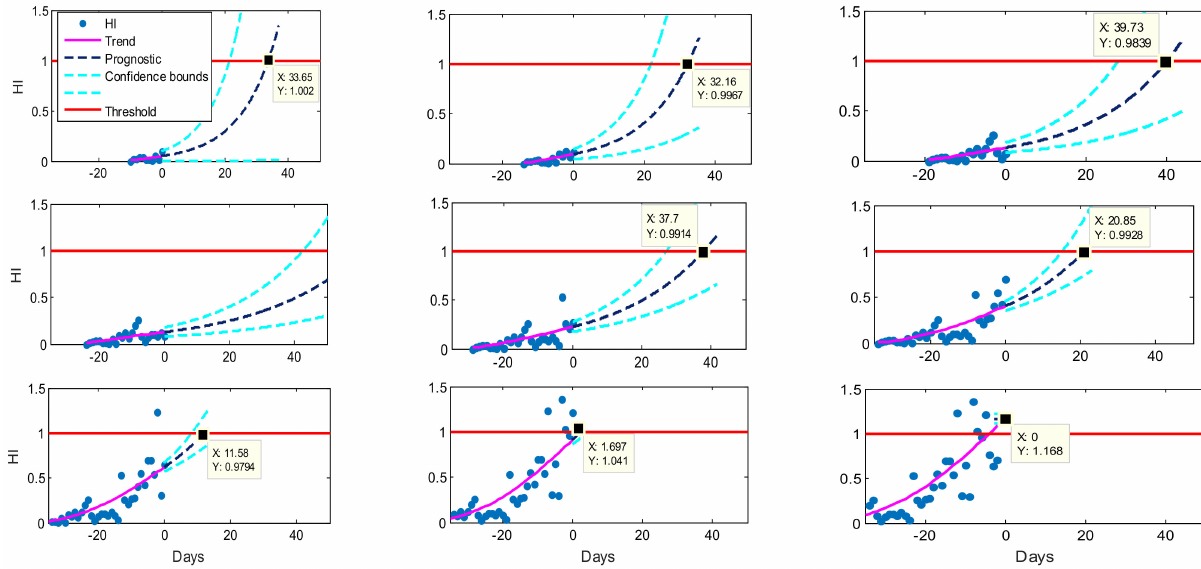
Figure 14. Estimated RUL every five days from initial low to the last high confidence prognostic with error bounds. Reproduced from